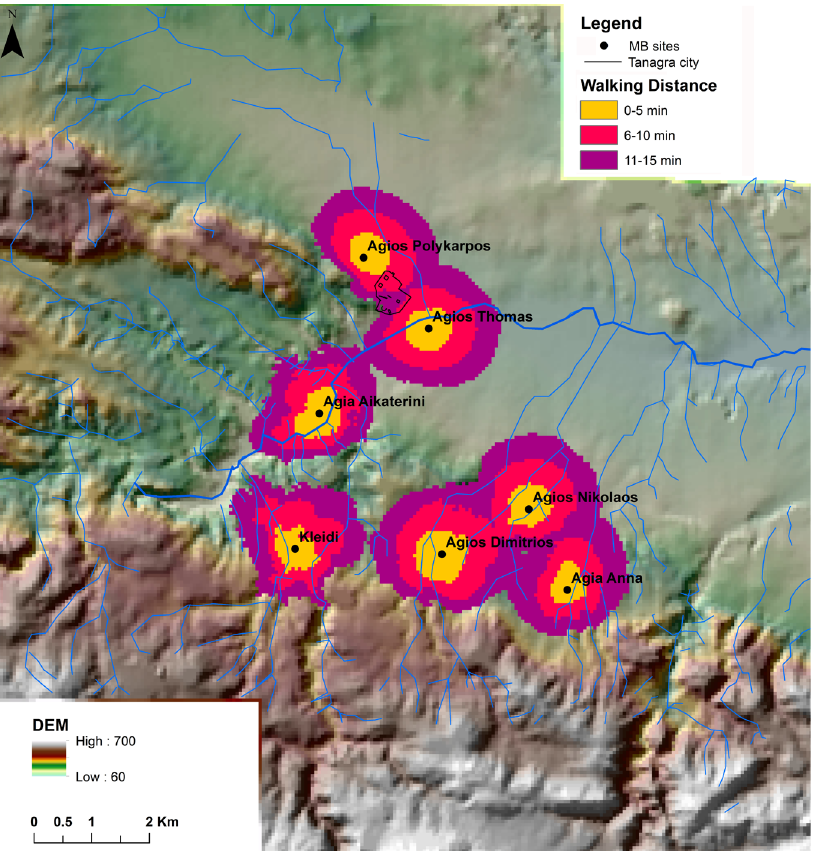
Figure 11: Cost-surface analysis of Middle Byzantine settlement sites in the area of Tanagra (central Greece), showing two major groups and village-community areas, i.e. Polykarpos-Thomas-Aikaterini and Nikolaos-Dimitrios-Anna (GIS analysis by Niki